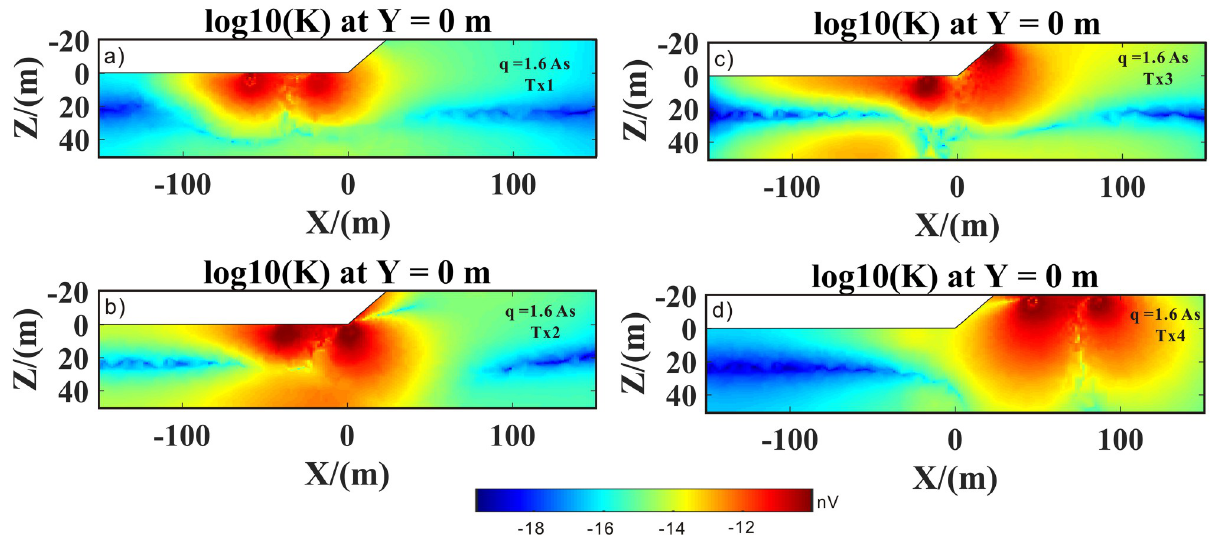
Fig 17. 3D SNMR kernel function of the Tx1–Tx4 transmit coils, with 1.6 As pulse moment.